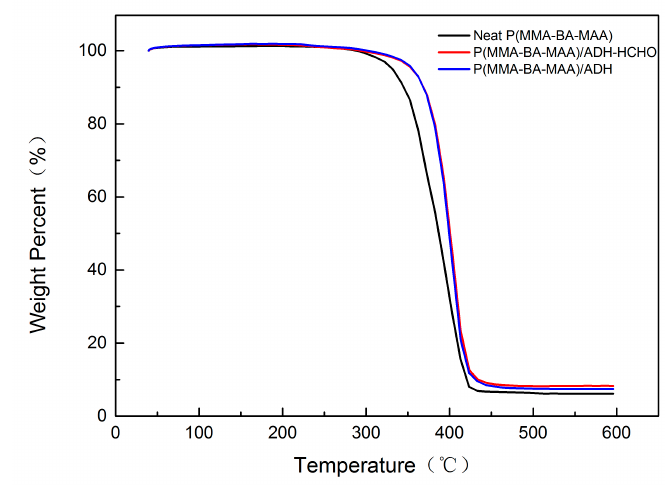
Figure 9. Thermo gravimetric analysis (TGA) curves for neat P(MMA-BA-MAA), P(MMA-BA-MAA)/ADH, and P(MMA-BA-MAA)/ADH-formaldehyde (HCHO) hybrid films. Table 3. Thermal properties of poly (methyl methacrylate-butyl acrylate-methacrylic acid) (P(MMA-BA-MAA)), P(MMA-BA-MAA)/ADH, and P(MMA-BA-MAA)/ADH-HCHO TGA-thermo gravimetric analysis. TGA Data Sample Neat polymer ADH/polymer